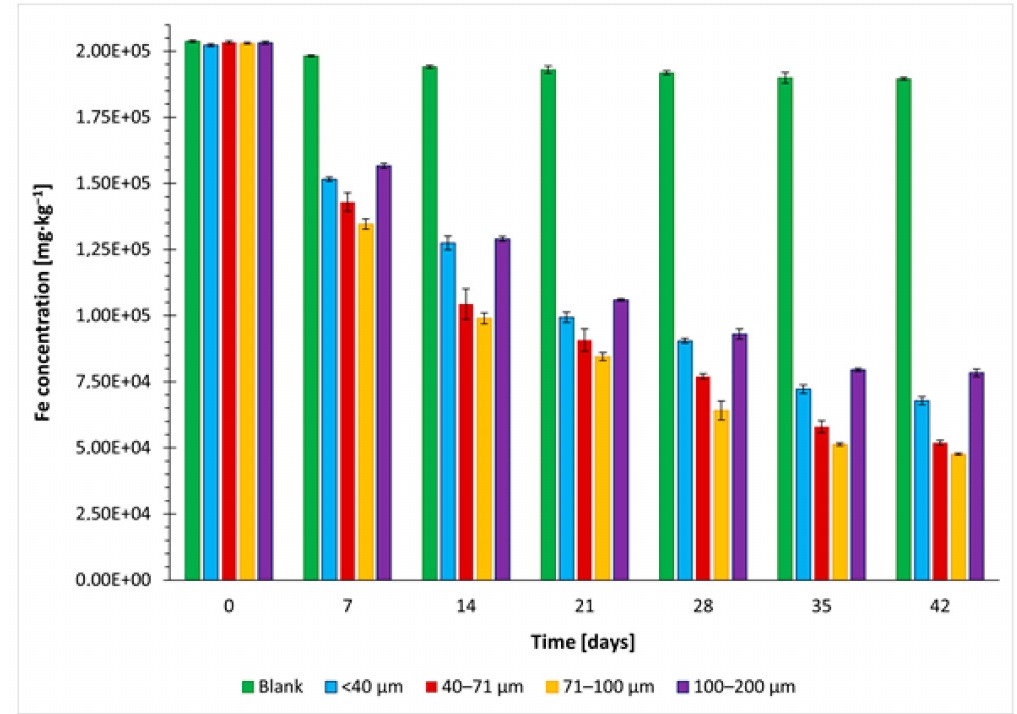
Figure 6. Concentration loss of Fe in waste material for individual grain